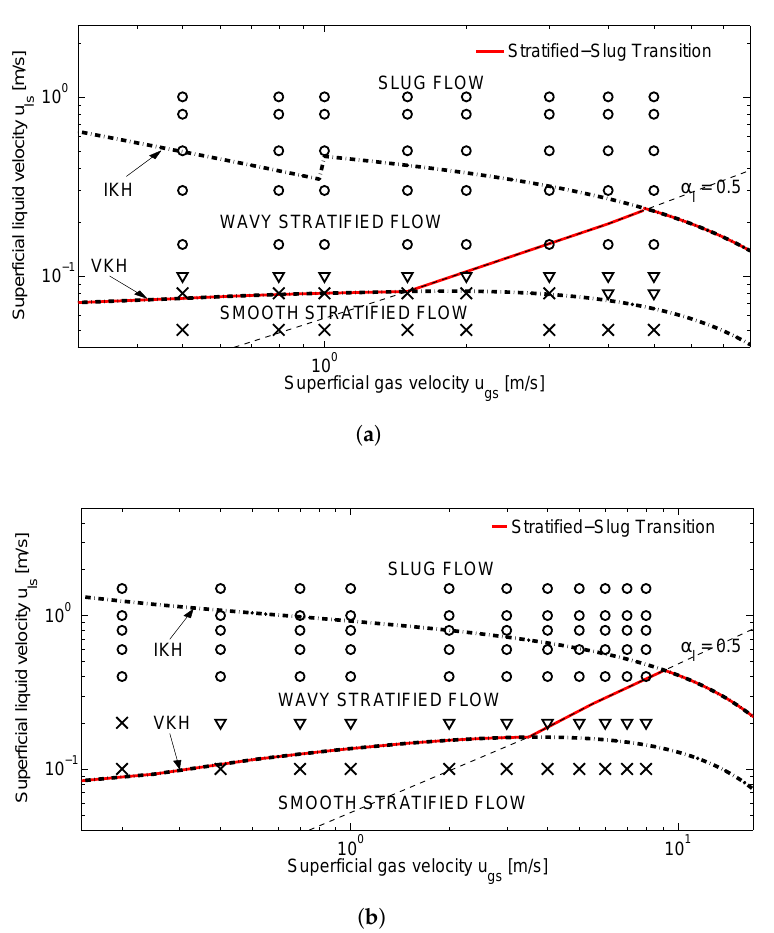
Figure 4. Flow pattern maps. Points stand for the simulation results; × : smooth stratified flow, (cid:53) : wavy stratified flow, ◦ : slug flow. Comparison against the theoretical Viscous Kelvin–Helmholtz (VKH) line and the Inviscid Kelvin–Helmholtz (IKH) line. ( a ) Pipe1 flow pattern map; and ( b ) Pipe2 flow pattern